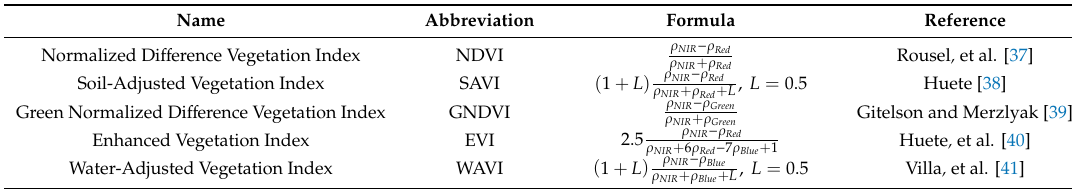
Table 2. Vegetation indices used in our